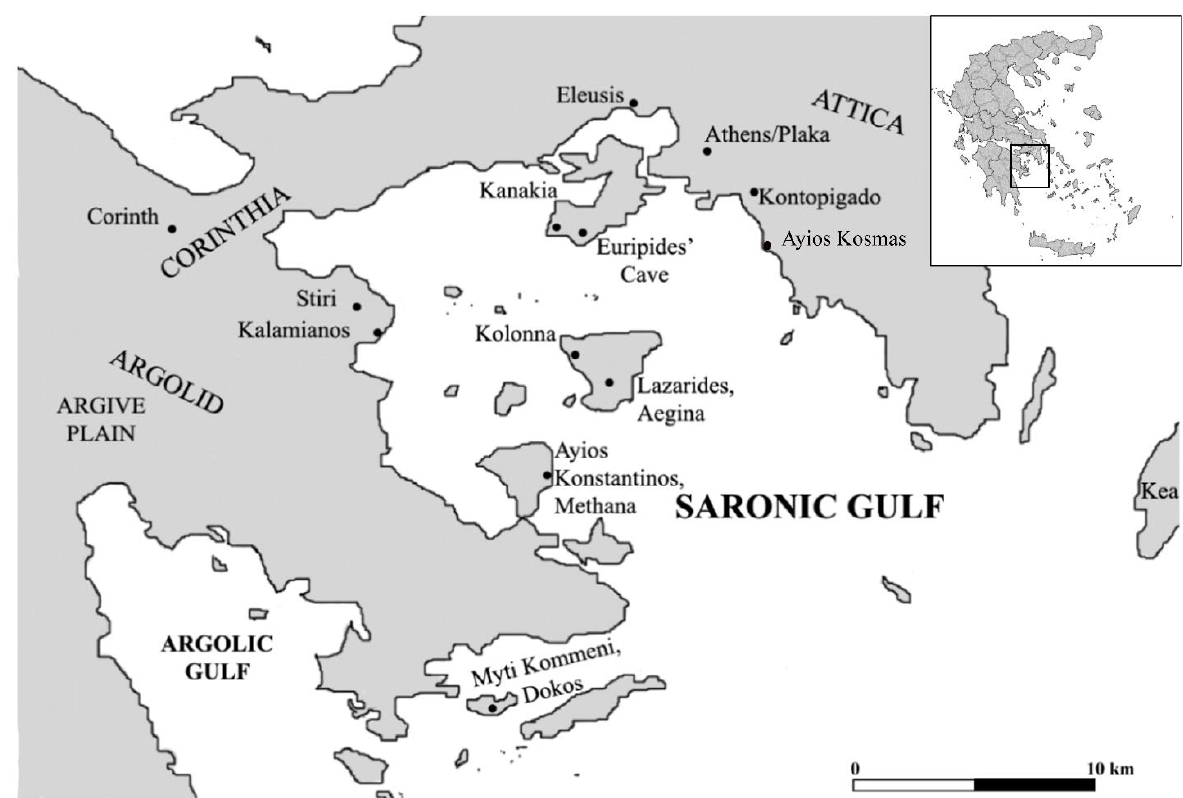
Figure 4. Map of the Saronic Gulf, Greece and all sites from within the study. Map by William Gilstrap.